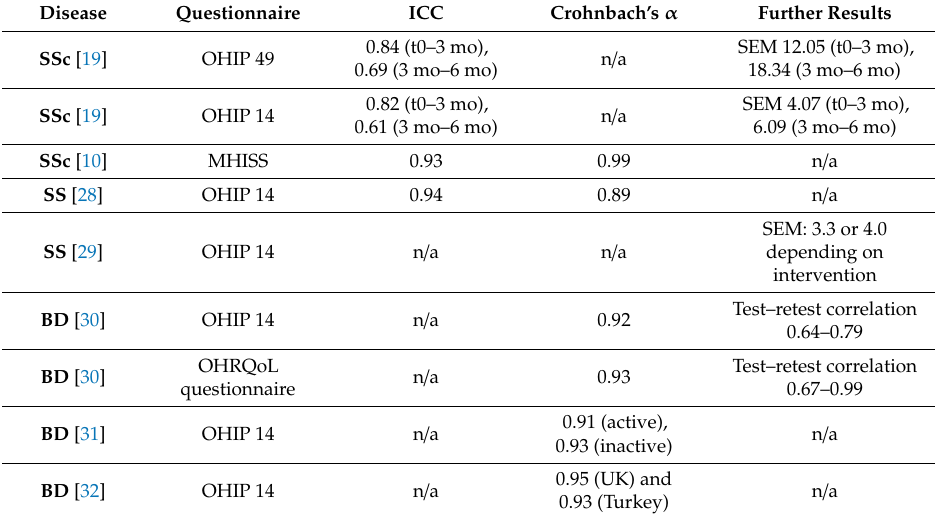
Table 5. Validity of the applied questionnaires for assessment of OHRQoL in patients with rheumatoid